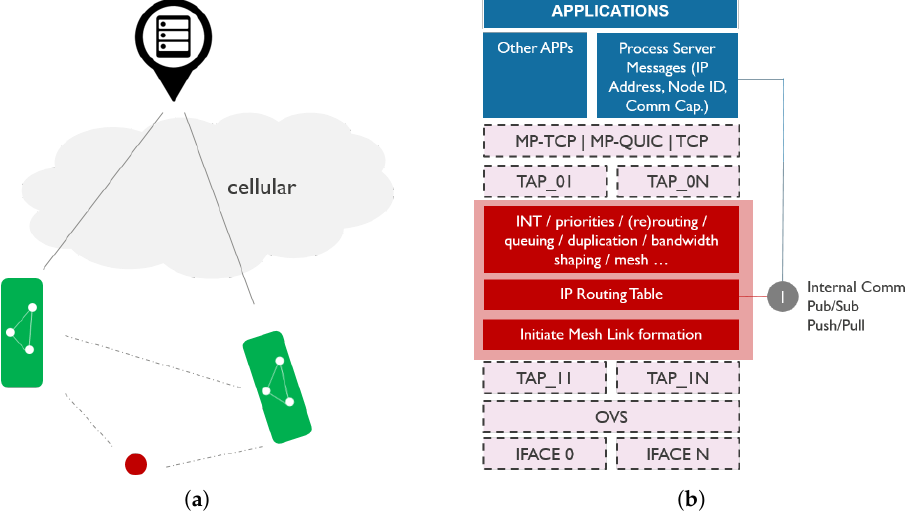
Figure 4. Centralized discovery including ( a ) schematic representation of network topology and ( b ) communication stack